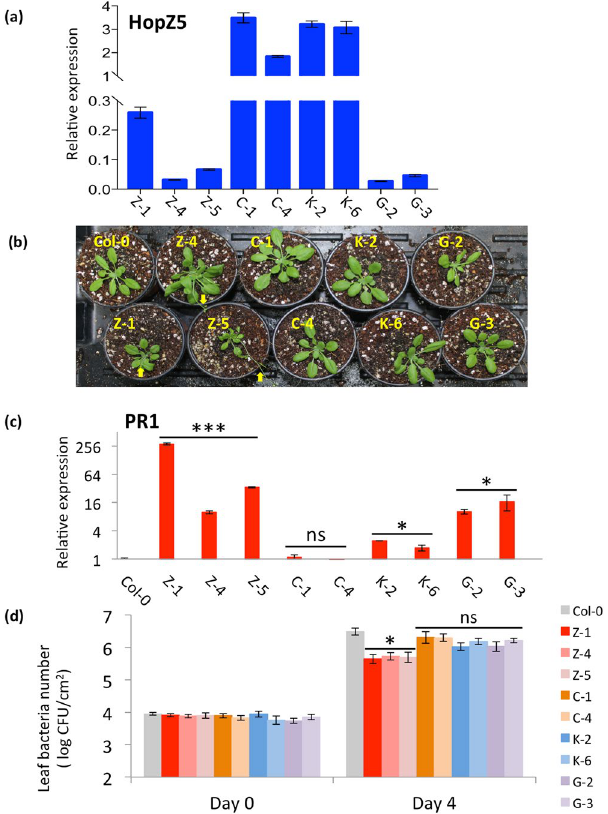
Figure 6. HopZ5 variants are compromised in their ability to trigger defence when overexpressed in Arabidopsis thaliana Col-0. ( a ) hopZ5 -transgene expression was determined in hopZ5 stable expression lines in the Col-0 background. 15–20 T2 seedlings from two or three independent lines per hopZ5 variant ( hopZ5 - wild-type: Z-1, Z-4, Z-5; C218A : C-1, C-4; K278R : K-2, K-6; G2A : G-2, G-3) were harvested after selection for three weeks on solid media containing kanamycin. RNA was extracted and cDNA synthesized and used for quantitative polymerase chain reaction (qPCR) for the hopZ5-YFP transgene. Expression is relative to internal EF1 α expression only. Error bars indicate standard error from three technical replicates. Asterisks indicate results of Student’s t-test between selected sample and Col-0 wild-type also grown on plates but without kanamycin; *** ( P < 0.0001). This experiment was conducted three times with similar results. ( b ) Stable transgenic lines expressing wild-type HopZ5 show altered morphology. 2-week-old T2 plants as in ( a ) were transferred to soil after selection on kanamycin. Photographs are of representative 5-week-old plants that showed a differential phenotype only. Typically between 1-in-3 (Z-1) to 1-in-4 plants (Z-4 and Z-5) showed a stunted/early flowering phenotype, putatively representative of Mendelian segregation and individuals homozygous for the transgene. Yellow arrows indicate the inflorescence in the early-flowering plants. ( c ) PR1 marker gene expression was determined in hopZ5 stable expression lines as in ( a ). Expression is relative to internal EF1 α expression and PR1 expression for wildtype. Error bars indicate standard error from three technical replicates. Asterisks indicate results of Student’s t-test between selected sample and Col-0 wild-type also grown on plates but without kanamycin; *** ( P < 0.0001). This experiment was conducted three times with similar results. ( d ) Pto DC3000 growth in hopZ5 stable expression lines in Col-0. Pto DC3000 was blunt syringe-infiltrated at 5 × 10 5 CFU/mL into leaves of each stable expression line from ( a ) and bacterial growth was determined 4 days post-infection (4 dpi). Error bars represent standard error from six technical replicates. Asterisks indicate results of Student’s t -test between selected sample and Col-0 wild-type; ns ( P > 0.05), * ( P < 0.05), ** ( P < 0.01). The experiment was conducted three times with similar